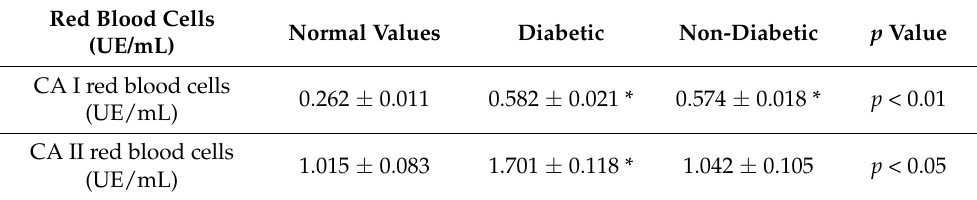
Table 7. The activity of CA isozymes in diabetic and non-diabetic patients.